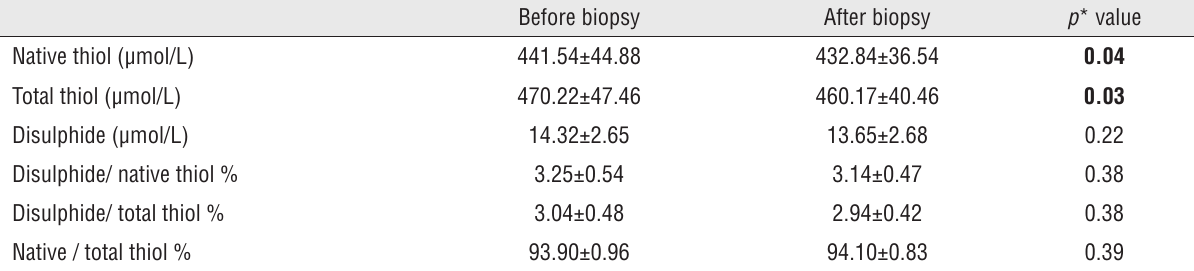
Table 2 - changes in the levels of oxidative stress markers after the biopsy procedure with relevant p values.